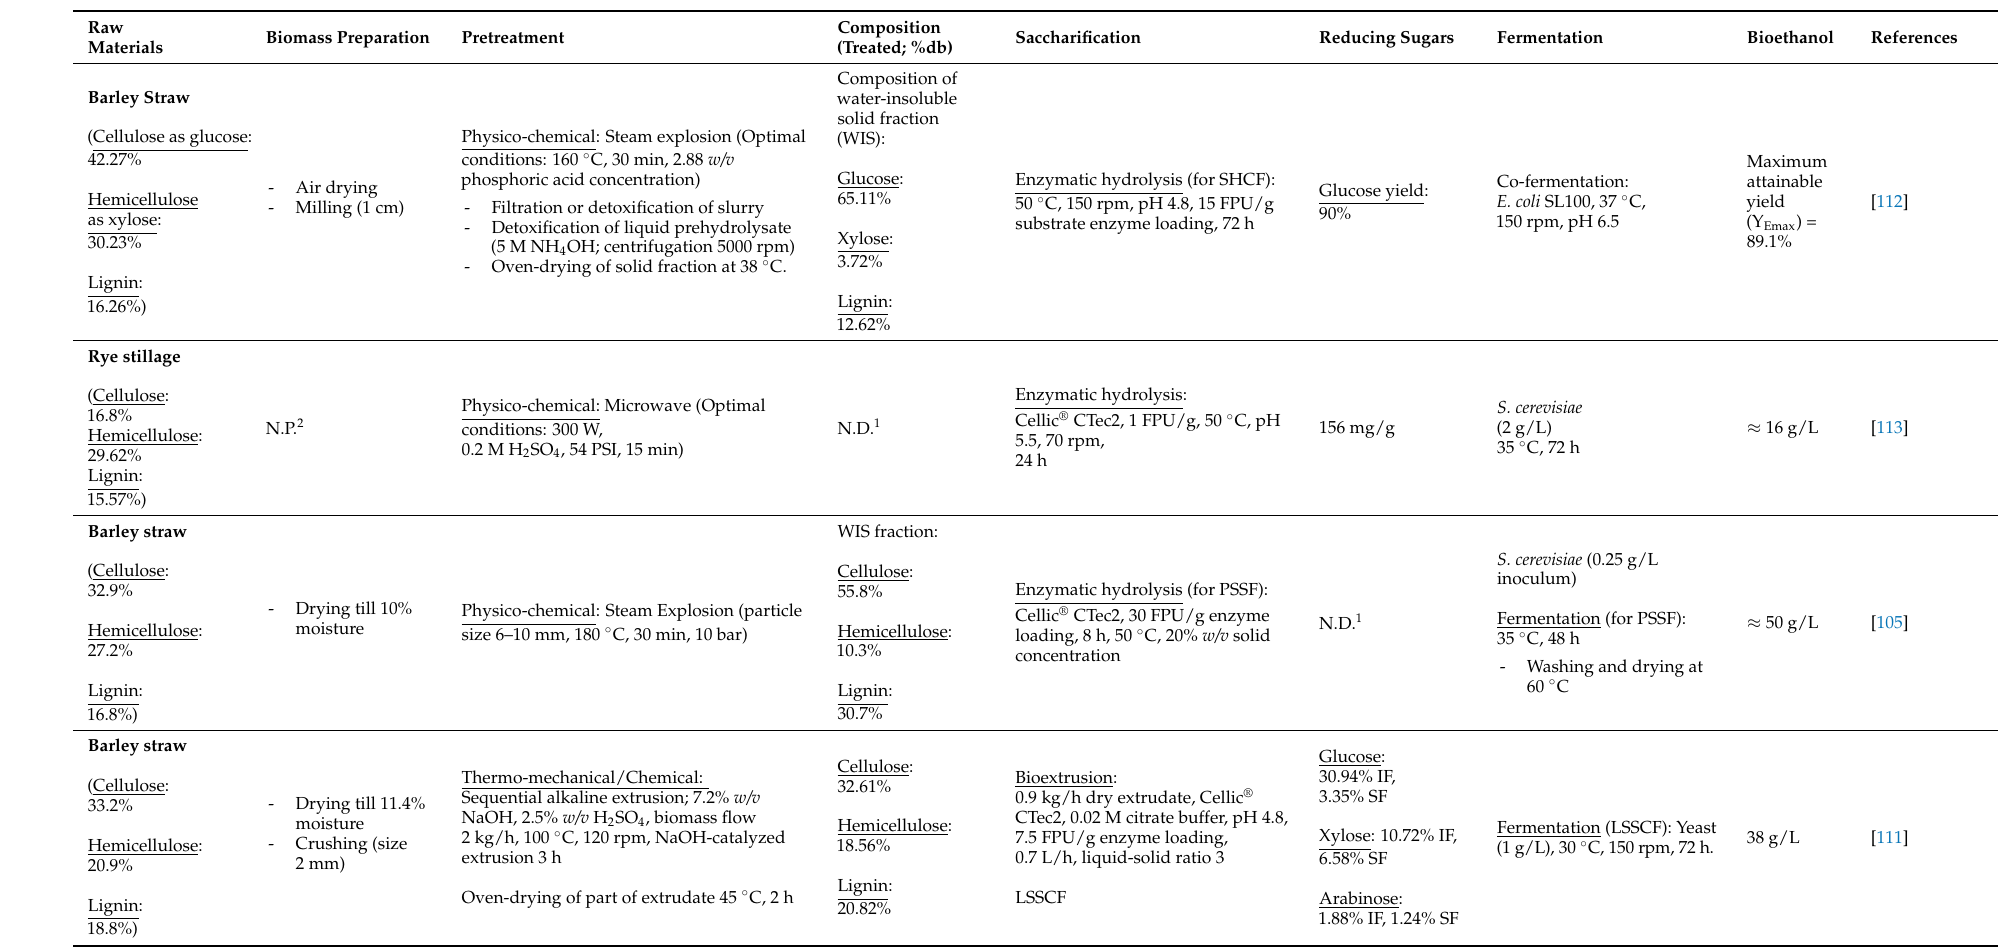
Table 8. Summary of experiments done for the pretreatment of other lignocellulosic